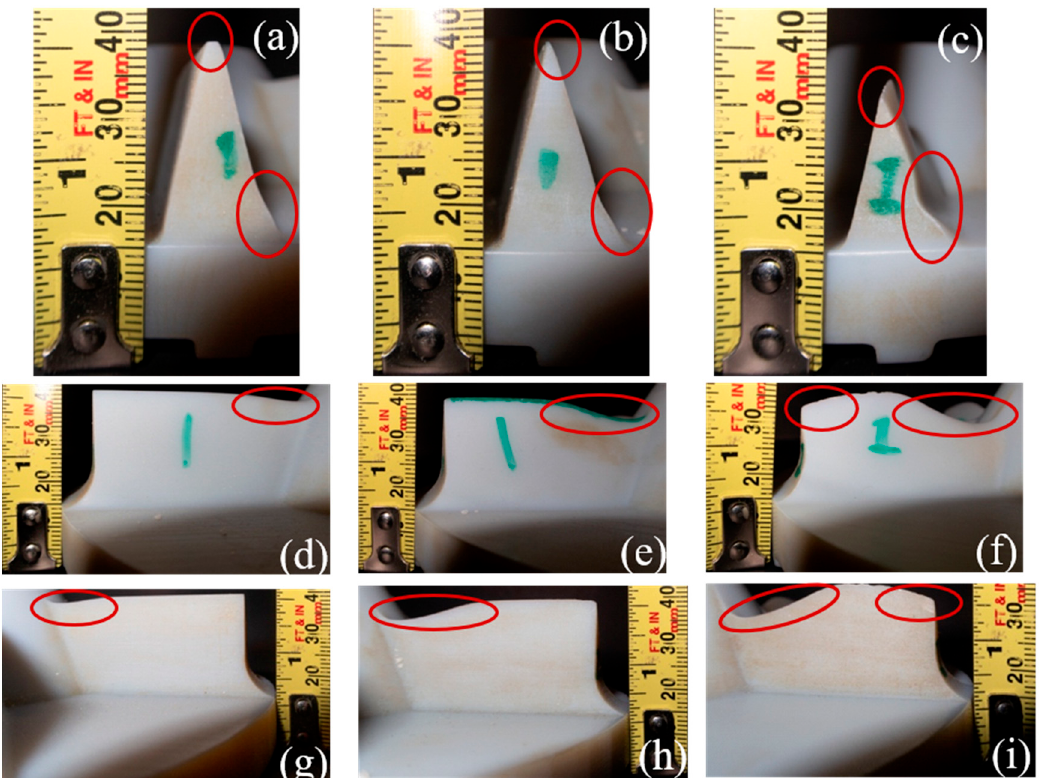
Figure 5. Wear patterns after different rotational speeds with 5 g/g (5 mass%) and 24 h: ( a ) 1200 rpm, worn surface at the end of blades; ( b ) 1500 rpm, worn surface at the end of blades; ( c ) 1750 rpm, worn surface at the end of blades; ( d ) 1200 rpm, worn surface at suction side; ( e ) 1500 rpm, worn surface at suction side; ( f ) 1750 rpm, worn surface at suction side; ( g ) 1200 rpm, worn surface at pressure side; ( h ) 1500 rpm, worn surface at pressure side; ( i ) 1750 rpm, worn surface at pressure side.